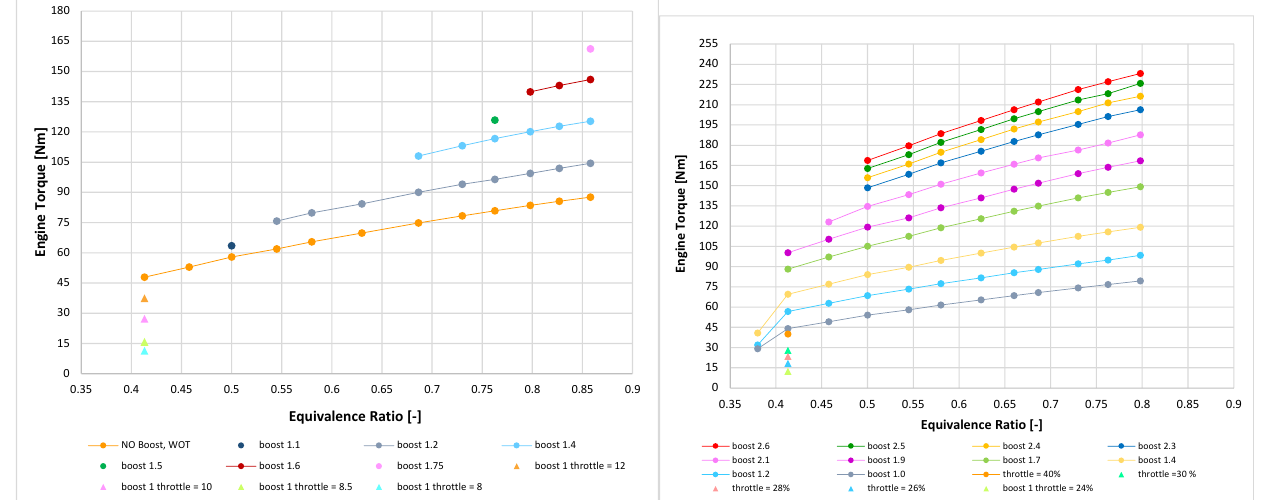
Figure 3. Engine torque as a function of equivalence ratio for different boost pressure levels. Engine speed 1500 rpm ( left ) and 3000 rpm ( right ). Circles stand for unthrottled operating conditions, triangles stand for throttled ones.